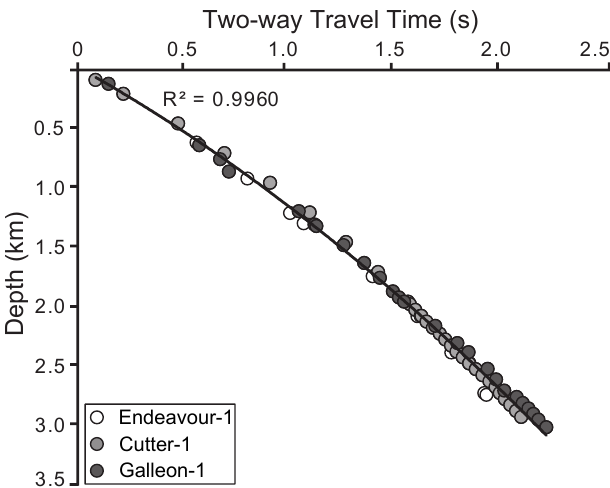
Figure 4: Two-way travel time versus depth curve for the Galleon-1, Cutter-1, and Endeavour-1